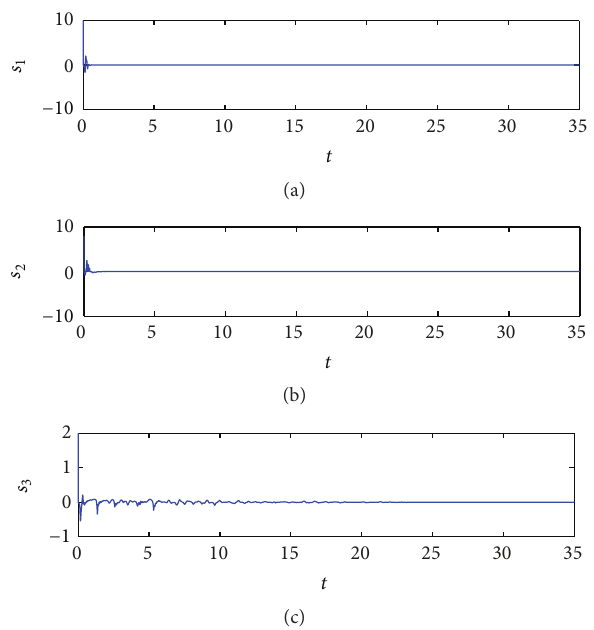
Figure 4: Time responses of the sliding mode surface 𝑠(𝑡) in Example 1.